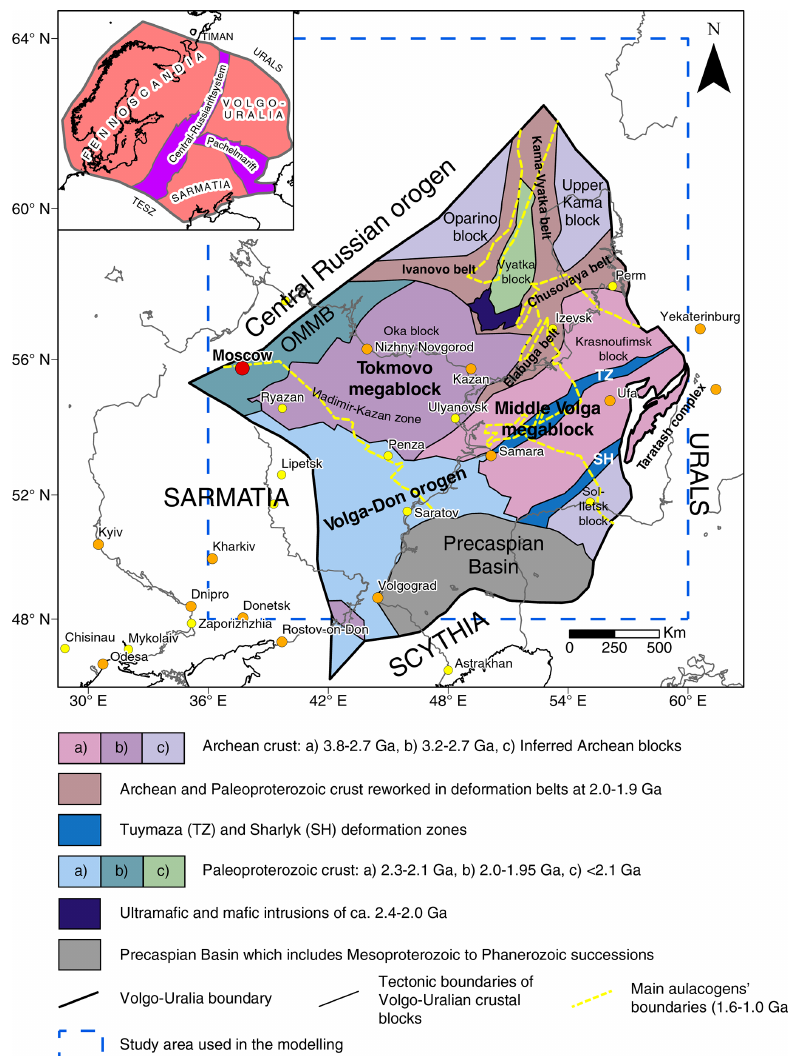
Figure 1. Main tectonic elements of Volgo–Uralian subcraton (redrawn after Bogdanova et al.,